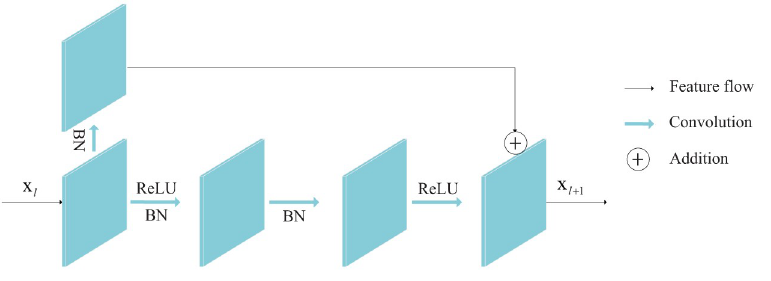
Fig 2. The structure of residual